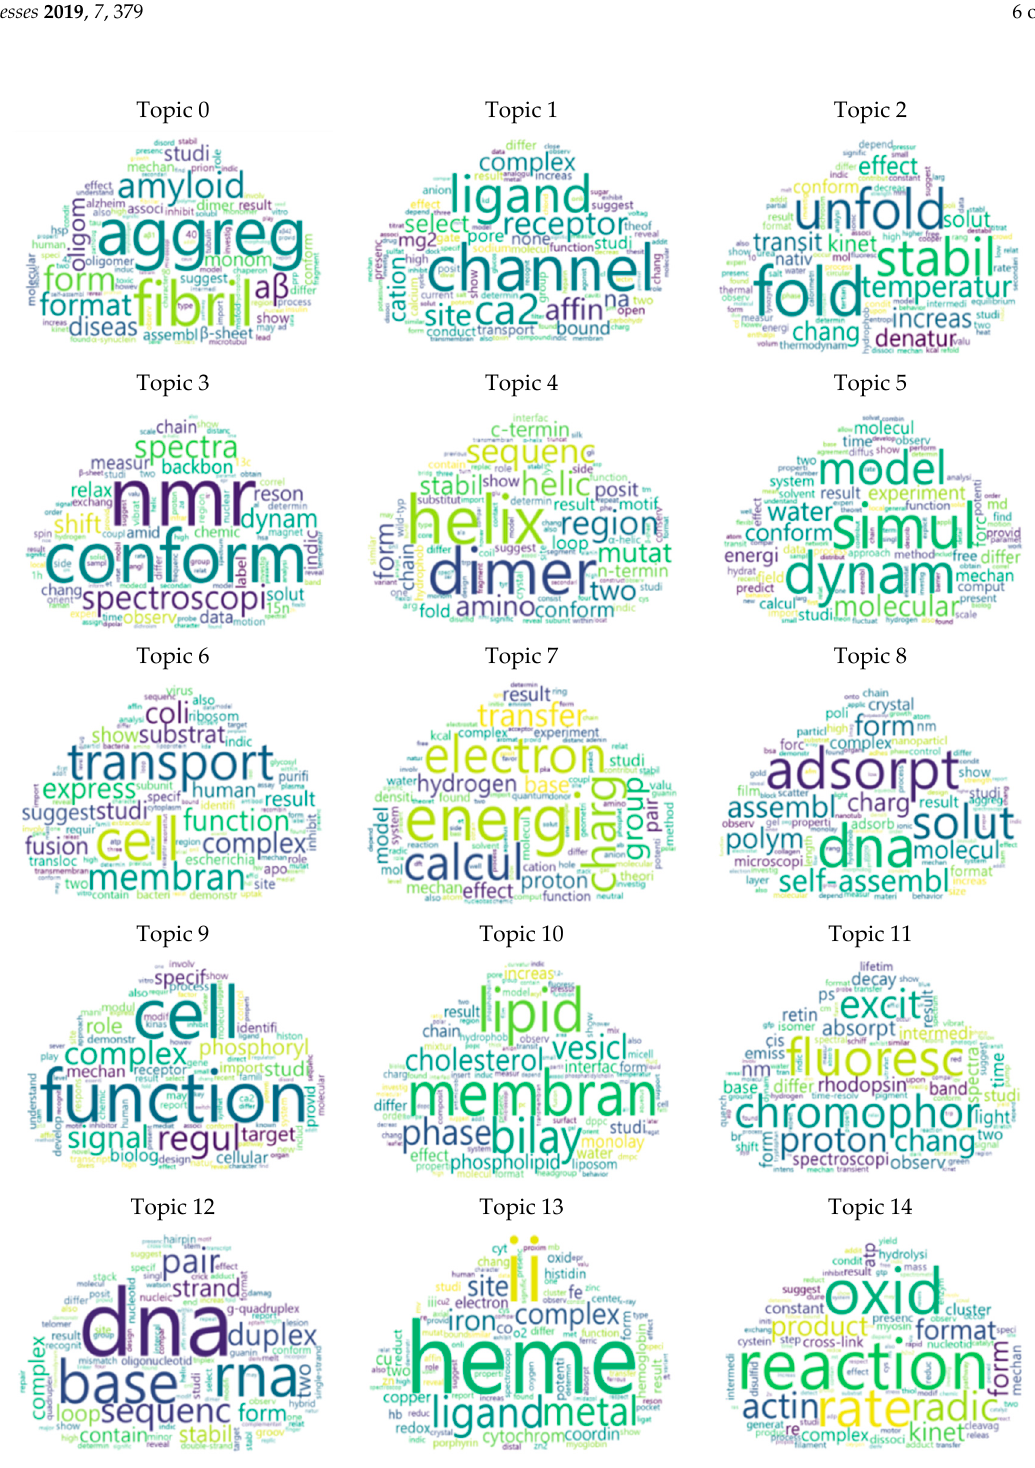
Figure 3. Word cloud by topic.